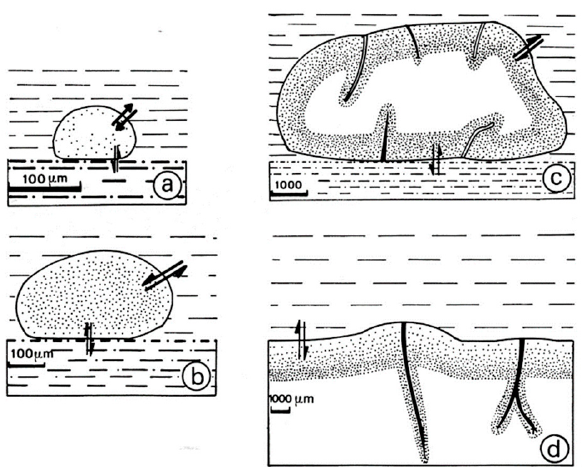
Figure 3. Glauconitization of substrates differing by size at the seawater (or interstitial water)–fecal pellet interface. ( a ) Small grains; ( b ) coarse grains; ( c ) lithoclasts; ( d ) hard ground. Small dots indicate the density of the glauconitization process and arrows represent cation exchange, after Odin and Matter [3].